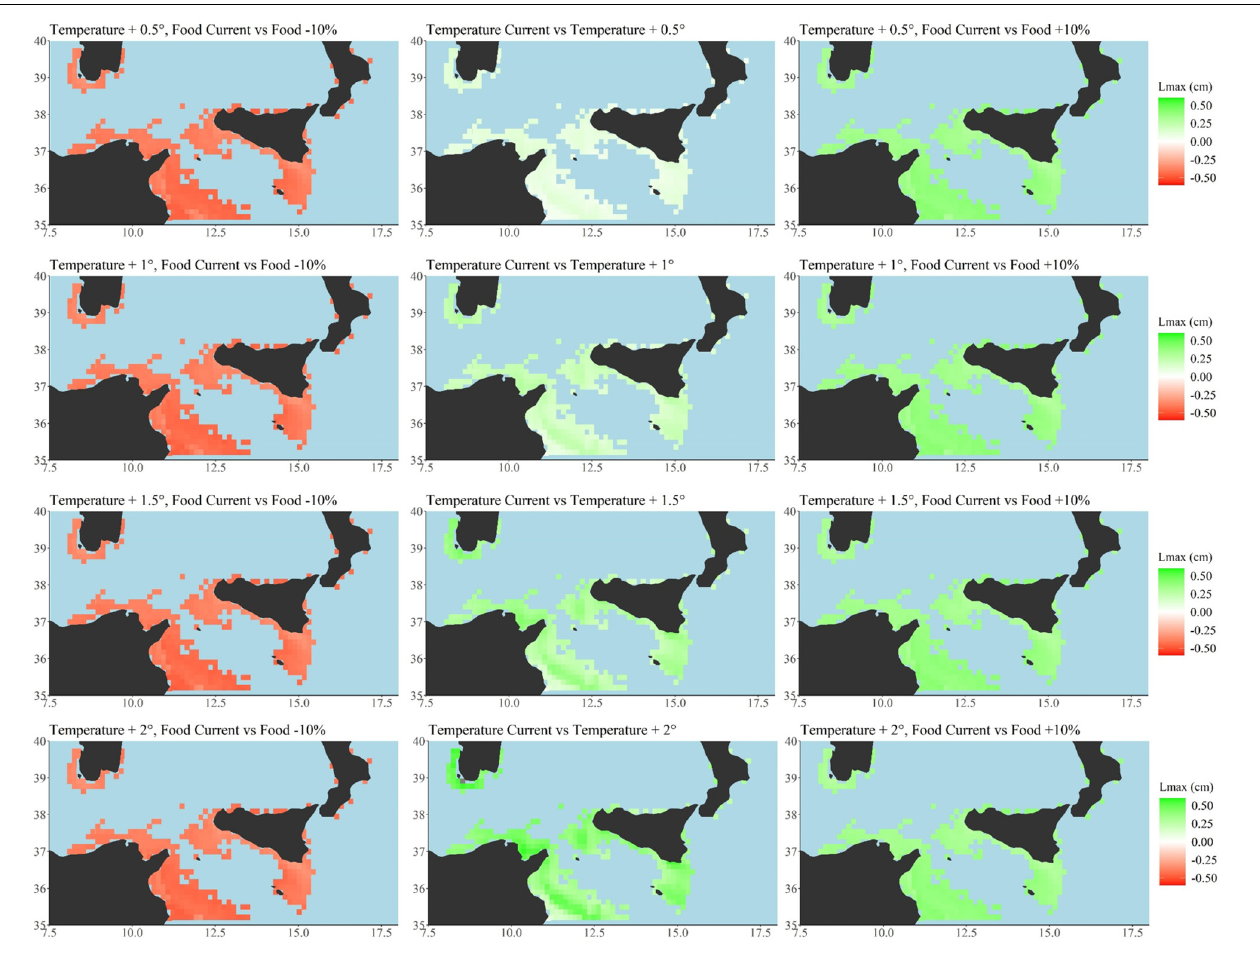
FIGURE 5 | Scenario-based quantitative maps showing differences between Maximum length (Lmax, cm) described by a continuous scale (from -0.48 to 0.46), respectively, across the examined temperature scenarios (central panel, current temperature vs. all the four temperature increasing scenarios of +0.5 ◦ C increase up to +2 ◦ C). Differences between current primary production food condition and oligotrophic, − 10%, food condition per each temperature scenarios (+0.5; +1.0; +1.5; +2.0 ◦ C, left side). Differences between current primary production food condition and eutrophic, +10%, food condition per each temperature scenarios (right side). Minimum, maximum, mean and median values for each scenario have been also reported as well as the global G statistic values at Supplementary Table S5 . Total number of cells = 346, cell resolution of 12.5 × 12.5 km 2 . Maps were created using R software (ggplot2